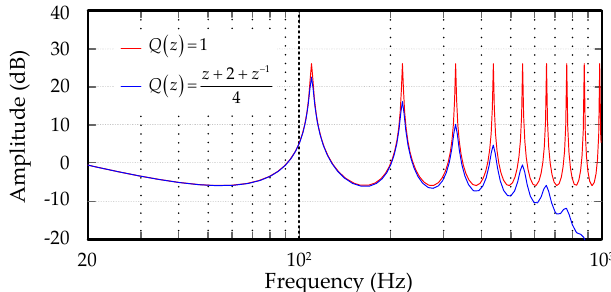
Due to the symmetry of Q ( z ) , its output has no phase shift relative to the input. When f e = 55 Hz k take 0.95, the amplitude-frequency characteristic curve of is shown in and c